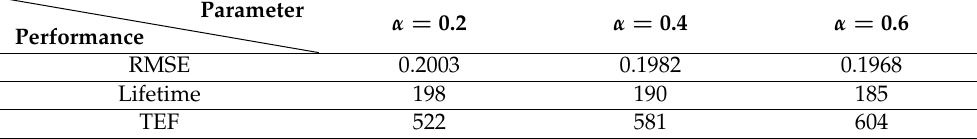
Table 5. The effect of different δ values on the performance of WSNs, when α = 0.3 and ∆ = 5. Performance